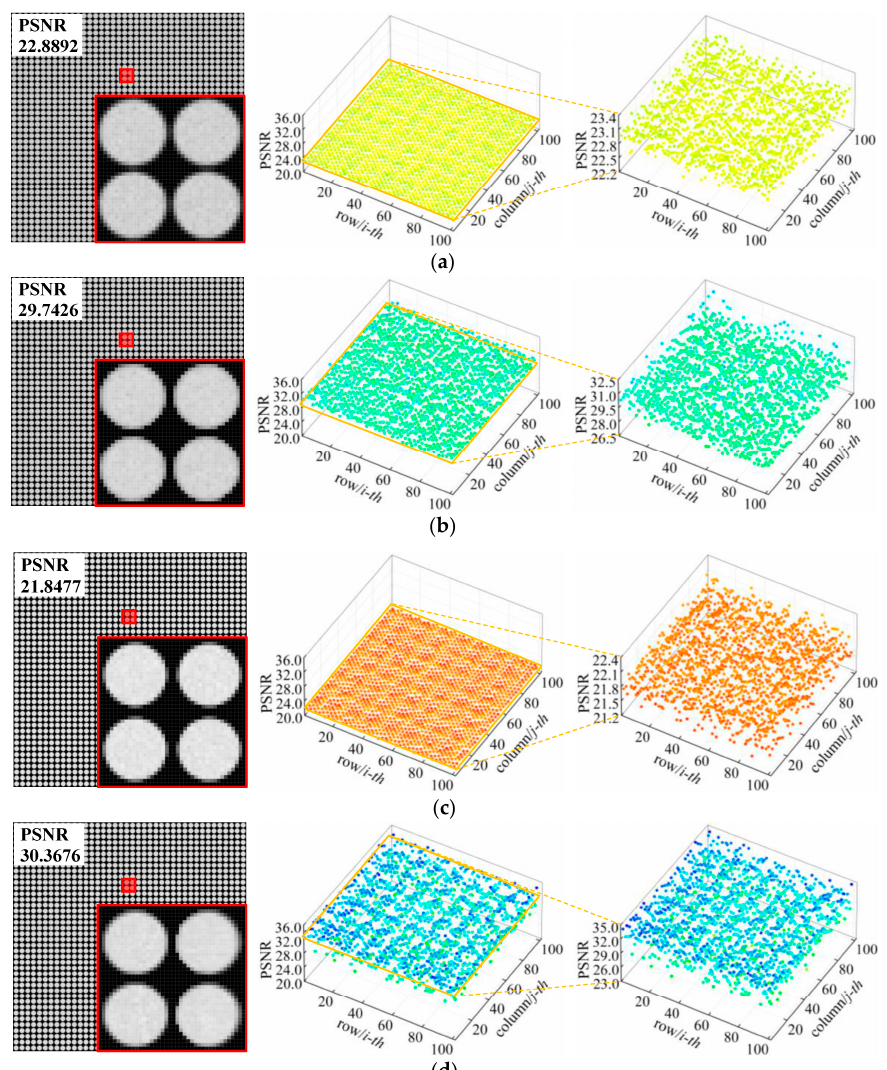
Figure 5. Correction results and deviation distributions for images with coupling distance error: ( a ) Distorted white raw image with an error of Δ z = − 15 μ m and ( b ) its corresponding corrected image; ( c ) Distorted white raw image with an error of Δ z = 15 μ m and ( d ) its corresponding corrected image. The PSNR values of each case are displayed in the upper left corner of the image.